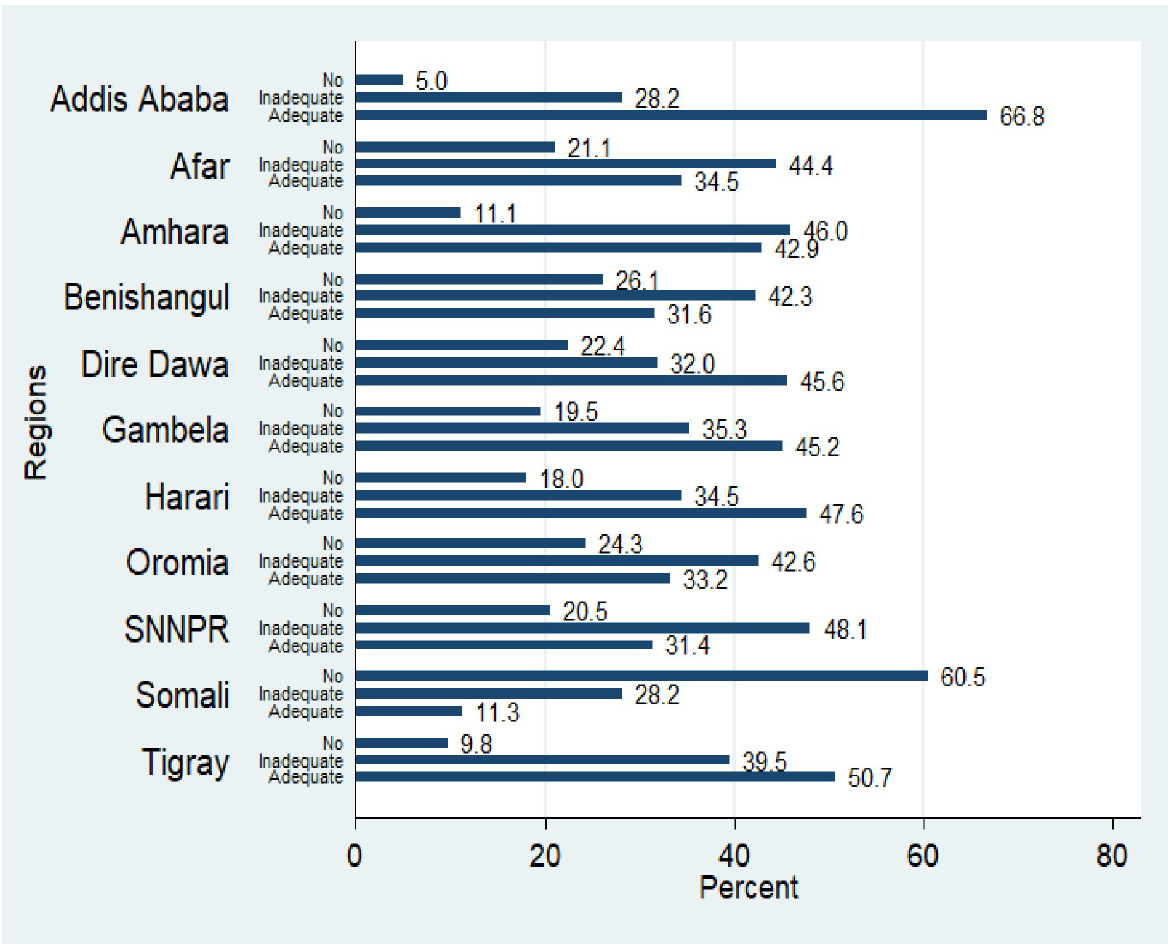
Fig 2. Levels of mother-to-child HIV transmission knowledge of Ethiopian reproductive-age women by regions in Ethiopia, 2016 EDHS.